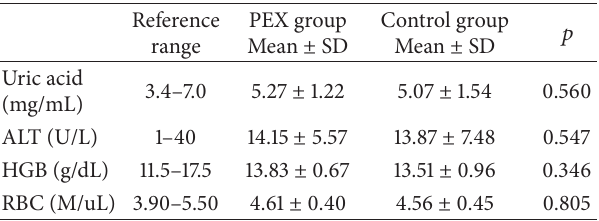
Table 2: Serum uric acid, alanine aminotransferase, hemoglobin levels, and red blood cell count of pseudoexfoliation ( 𝑛 = 31 ) and control groups ( 𝑛 = 34